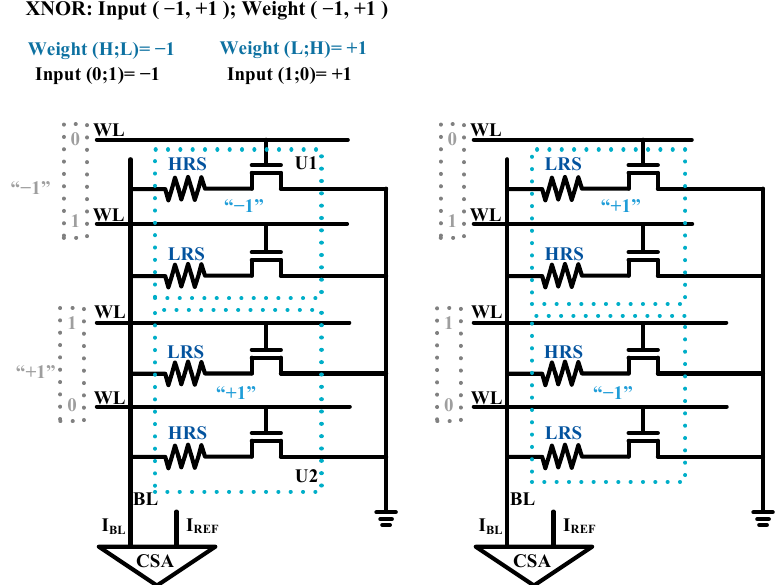
Figure 3. The sequential bit-cell design for X(N)OR implementation. Reprinted with permission from ref. [20]. Copyright @ 2018 IEEE.